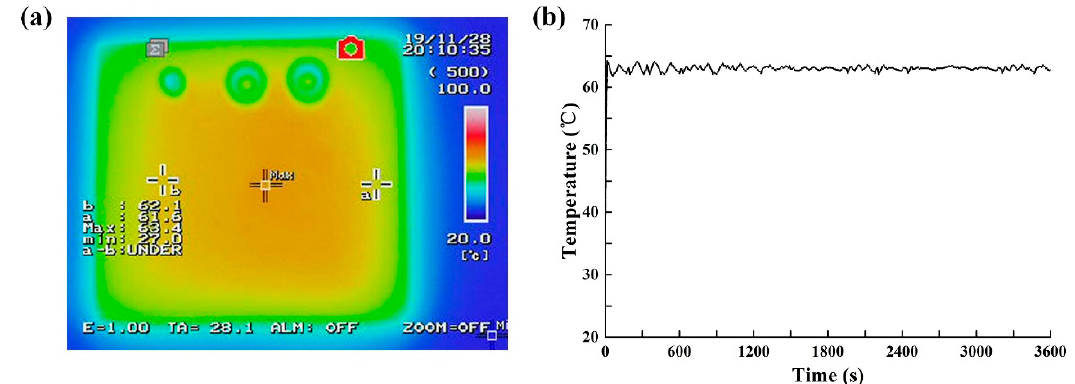
Figure 6. Chip heating performance. ( a ) Temperature field distribution. ( b ) Temperature stability.